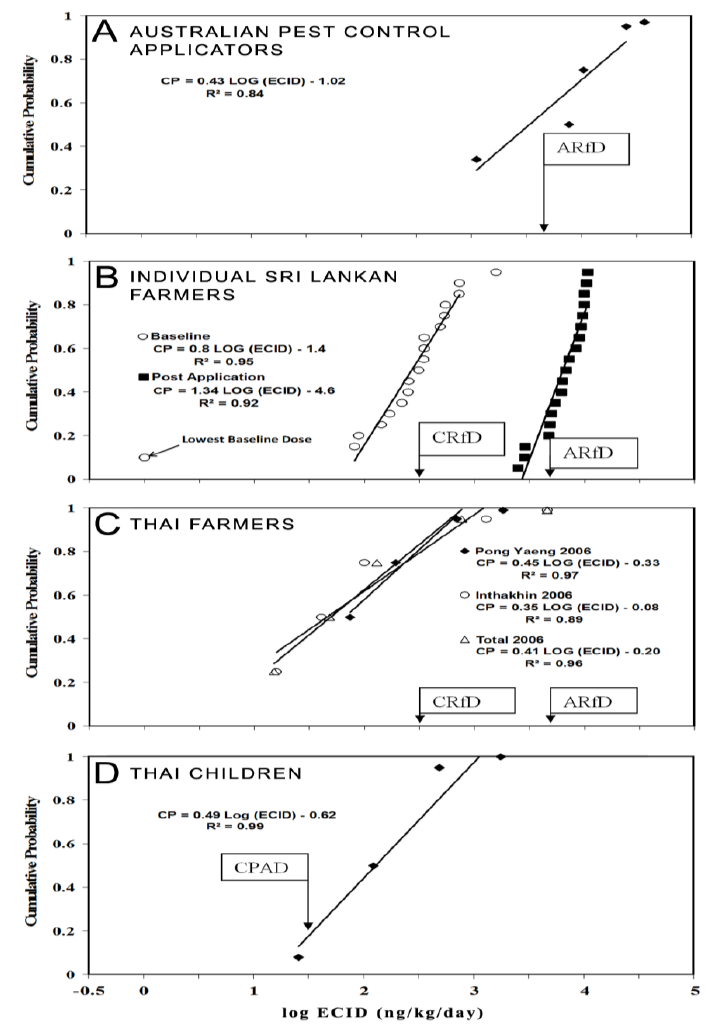
Figure 5. Cumulative probability distributions (CPD) for the ECID with the